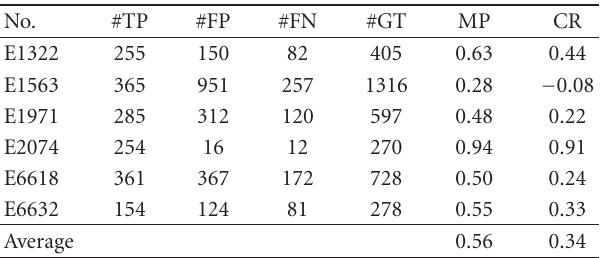
Table 3: The MP and CR value after AdaBoost classifier.